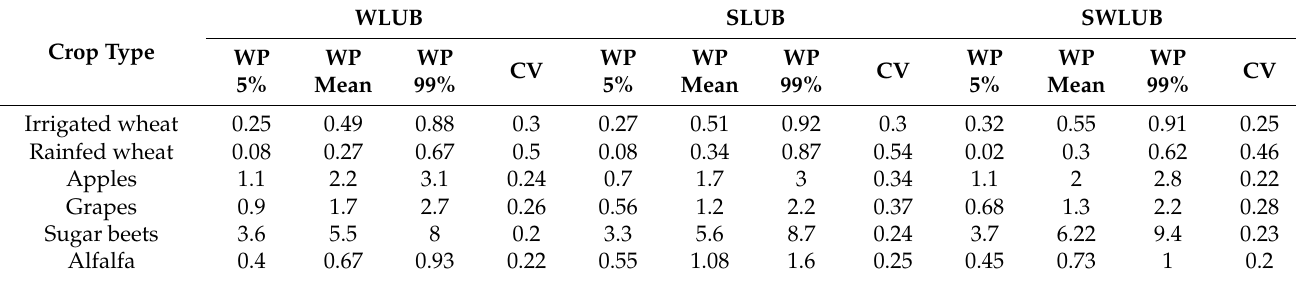
Table 3. Overview of WP mean, its relevant boundaries, and coefficient of variation (CV) for the selected crops in west of Lake Urmia (WLUB), South of Lake Urmia (SLUB), and southwest of Lake Urmia (SWLUB).